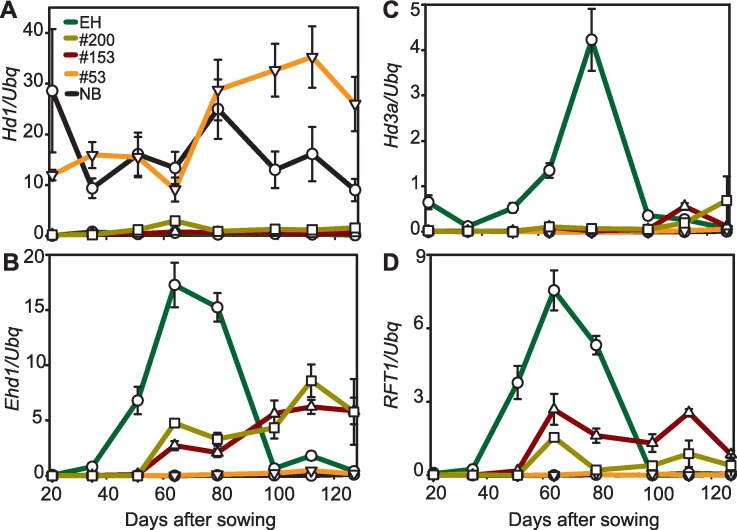
Expression of floral regulators is affected by the Hd1EH allele.B-E, Quantification of mRNA expression of Hd1 (B), Ehd1 (C), Hd3a (D) and RFT1 (E) from leaves of the indicated genotypes grown under LD (16L/8D). Transcription of Hd1EH is extremely low during the entire time course. Error bars indicate the standard deviation.